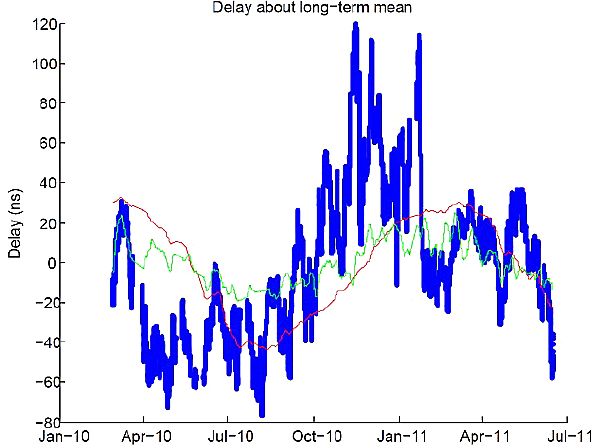
Figure 3. Comparison of the residual Loran-C delay (blue) with monthly SMOS SSS (red) on the practical salinity scale PSS (a di- mensionless quantity corresponding roughly to parts per